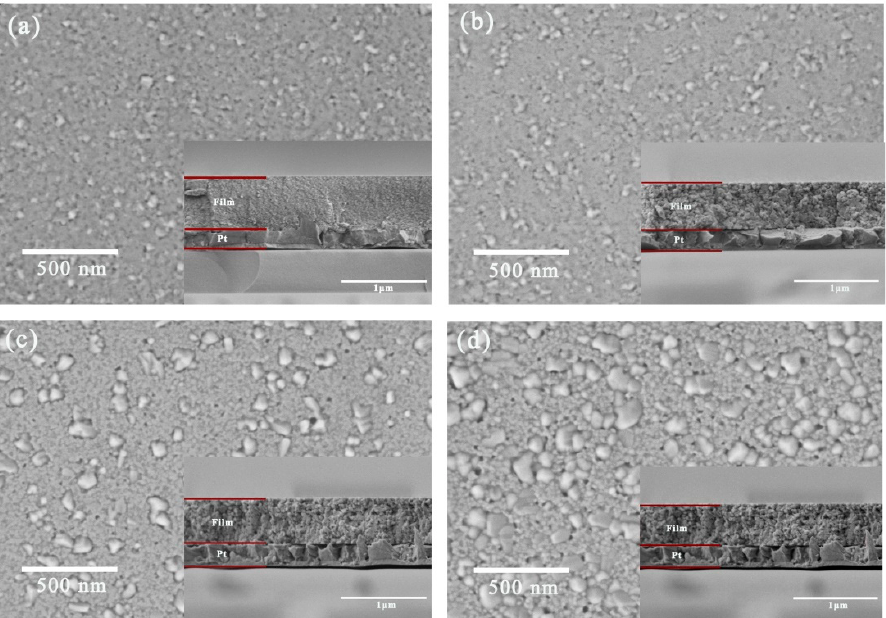
Figure 2. The scanning electron microscopic (SEM) images of the CBTi-BFO thin films annealed at ( a ) 450 °C, ( b ) 500 °C, ( c ) 550 °C and ( d ) 600 °C, and the inset shows their corresponding cross-sectional micrographs.